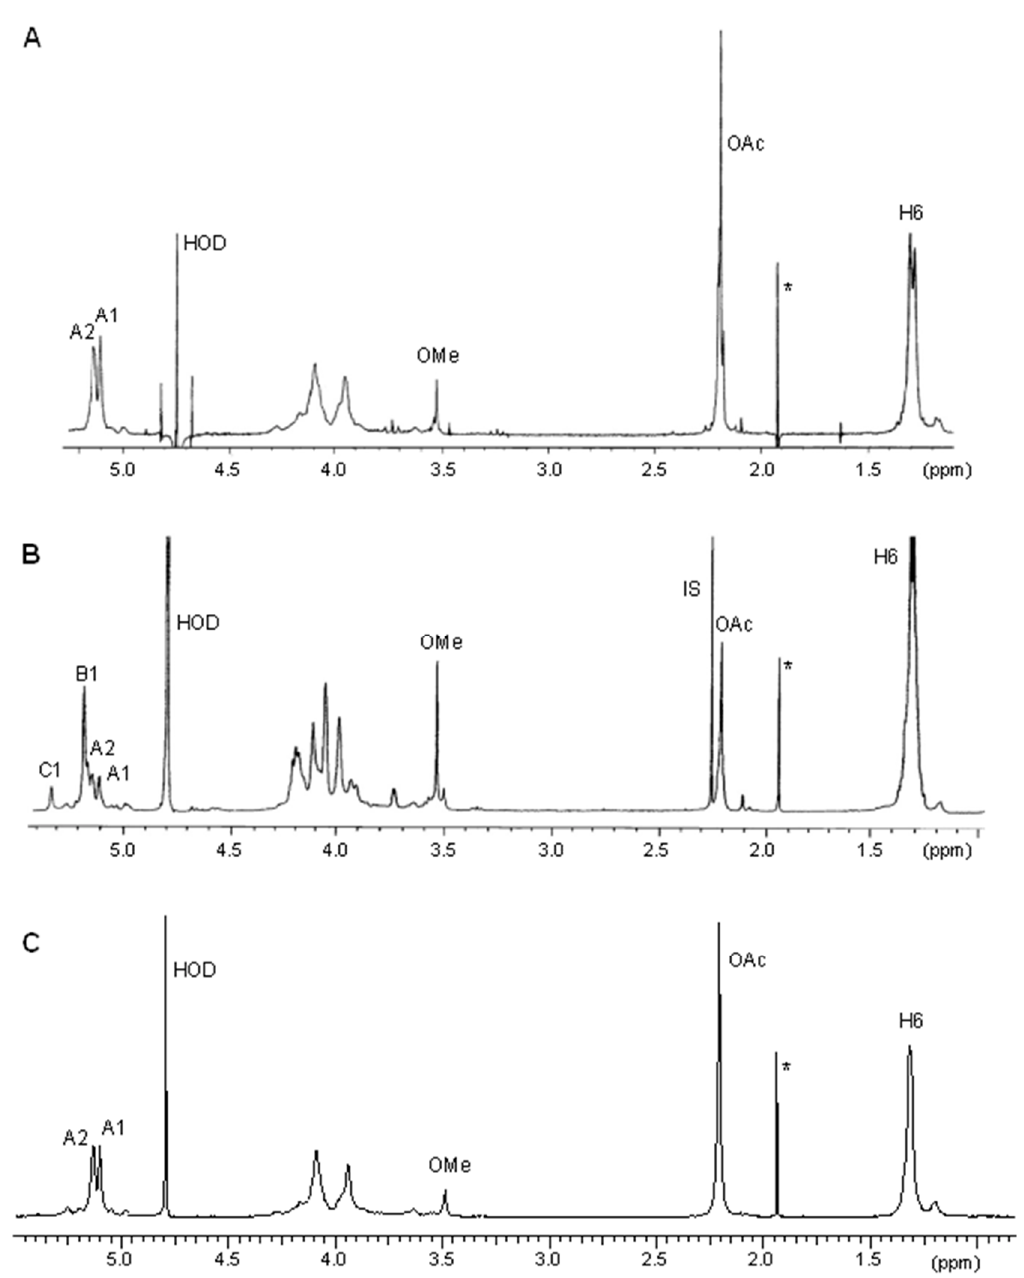
Figure 2. 1 H NMR spectra of the O-PSs of M. loti WT ( A ), NZP2213.1 mutant ( B ) and complemented ( C ) NZP2213.1(pBGoatB) strains. The O-PS samples were examined in 99.98% D 2 O using acetone ( δ H